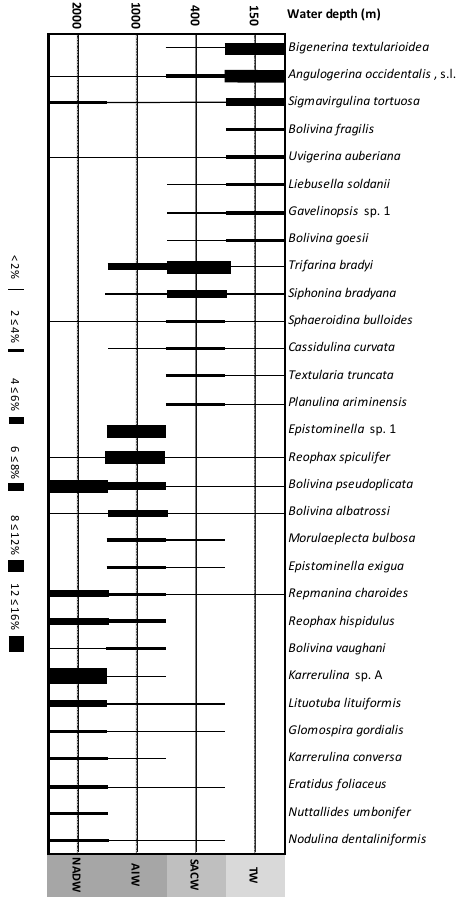
(b) Figure 7. The mean and standard deviation of foraminifera equitability ( a ) and dominance ( b ) along the isobaths at the studied layers. After integrating the layers, in general, the patterns observed in the surface are maintained for the community structure. These values are presented in Supplementary Materials Table S2.